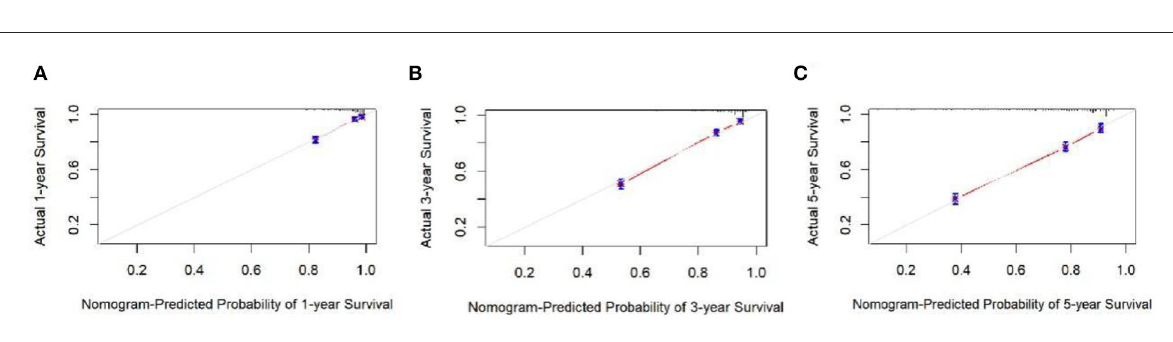
0.395 95% CI: 0.292–0.535), the surgical patient